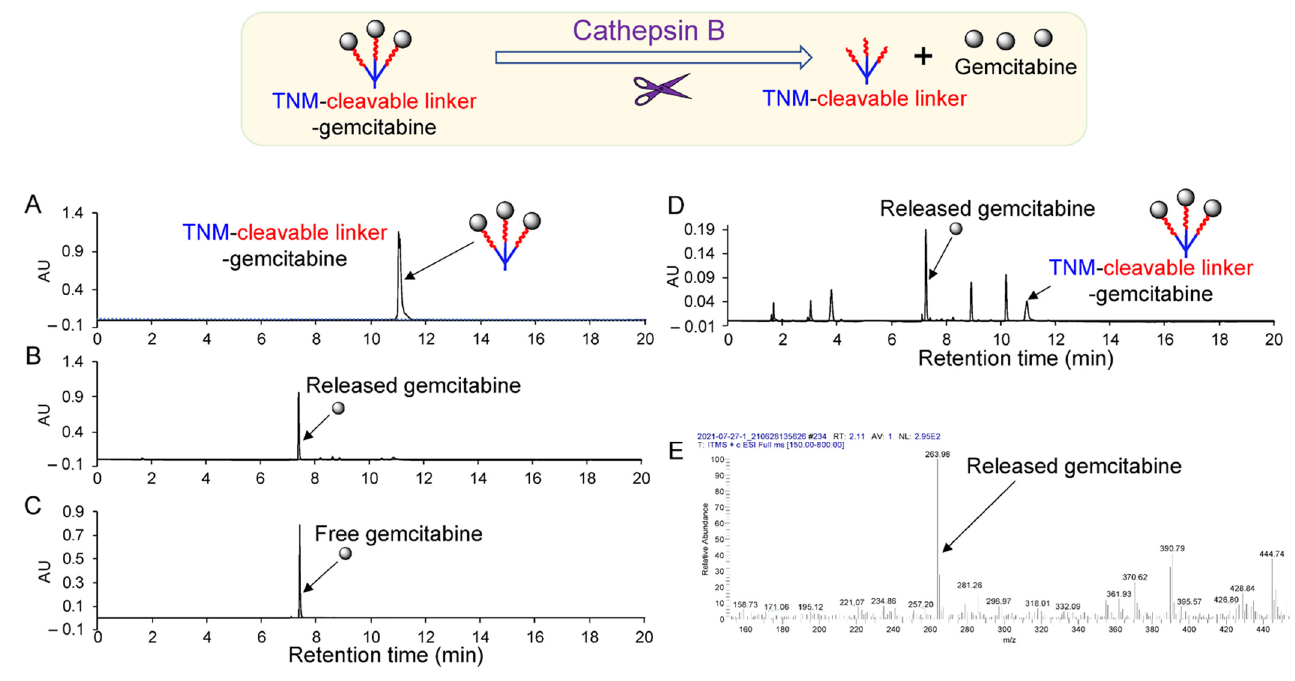
Figure 2. Characterization of enzymatically controlled drug release. ( A ) HPLC chromatogram of synthetic linker–gemcitabineTNM–linker–gemcitabine products. ( B ) Cathepsin B-mediated free